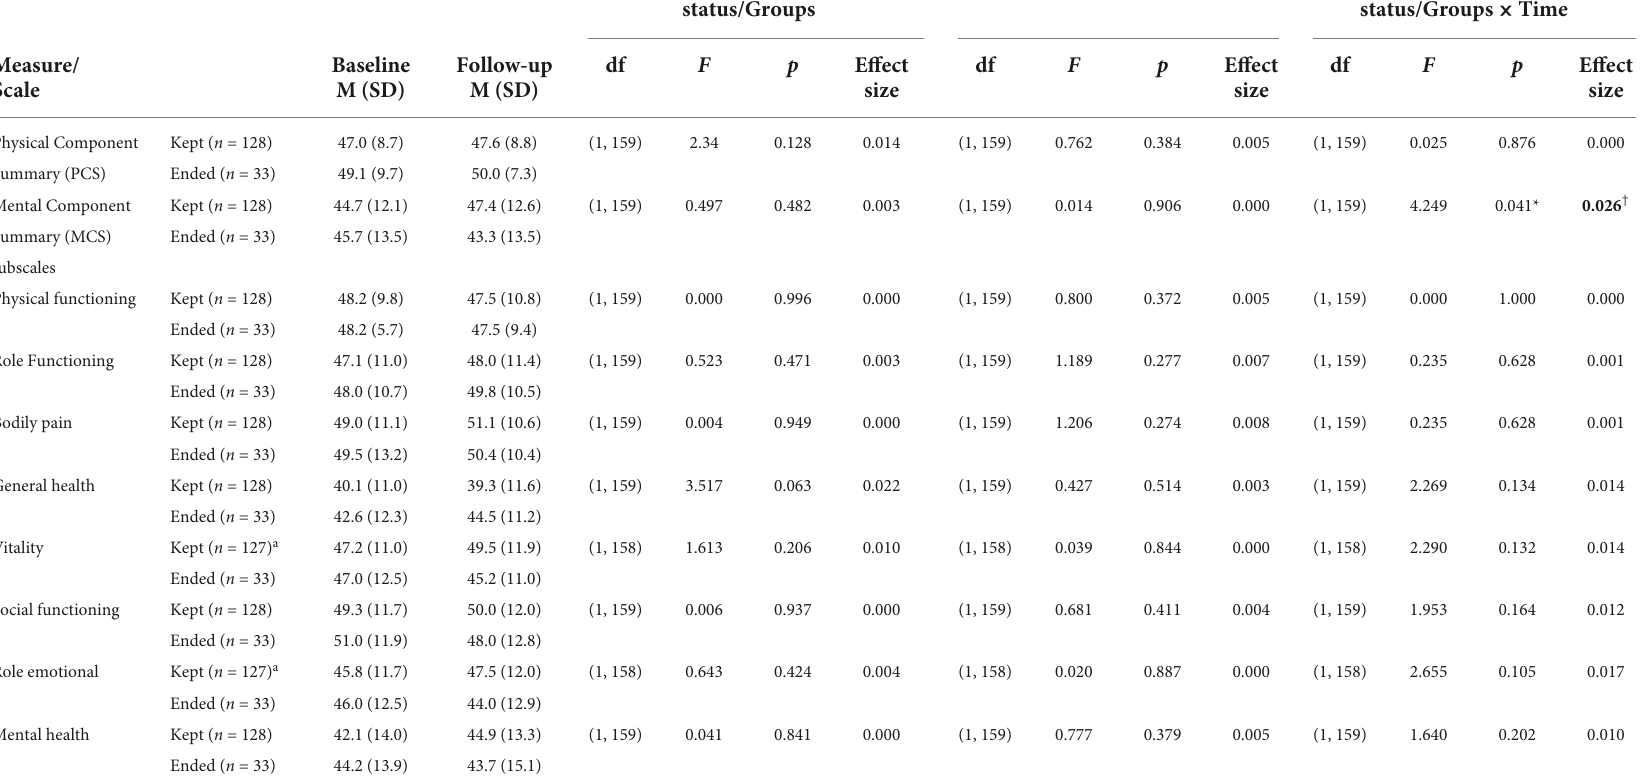
Caregivers’ status/Groups